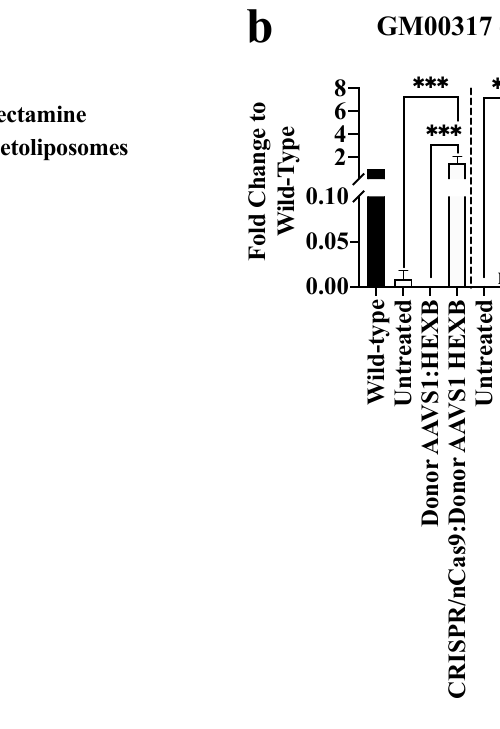
Figure 4. Transcription assays on long-term edited GM2 fibroblasts. The fold-change in the mRNA levels for GM00515-TSD ( a ) and GM00317-SD ( b ) fibroblasts one-month post-treatment are shown ( n = 3). * p ≤ 0.05, *** p ≤ 0.001. GM00515-TSD and GM00317-SD were analyzed using the two-tailed Student’s t -test and Mann–Whitney U test,